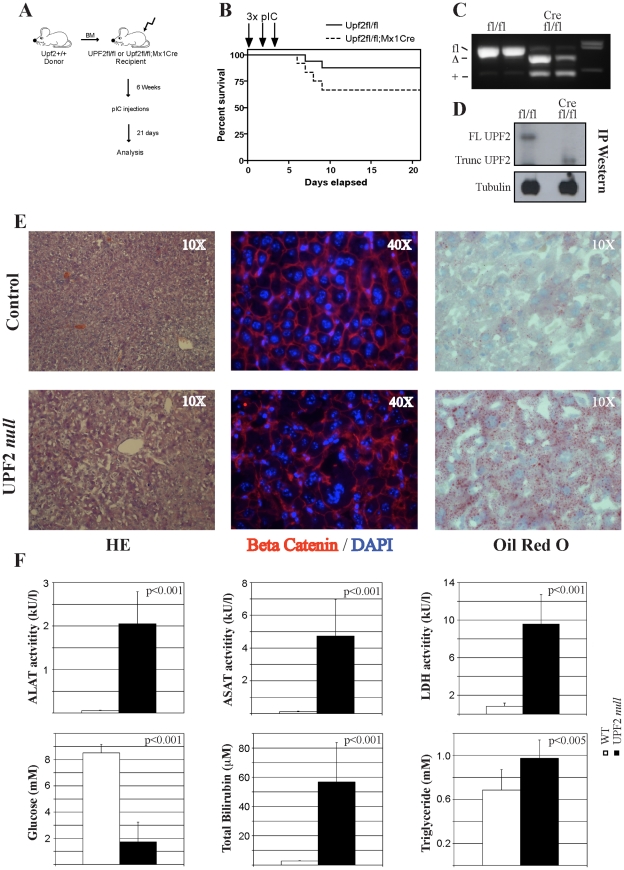
UPF2 is essential for homeostasis of the adult liver.(A) Experimental strategy for the induction of UPF2 loss in the adult liver of BM transplanted control (Upf2fl/fl) and Upf2fl/fl;Mx1Cre mice. (B) BM transplantation rescues the lethality of Upf2fl/fl;Mx1Cre mice. (C) Genotyping of BM transplanted (control and UPF2 null mice 3 weeks after the first pIC injection demonstrates efficient deletion in liver. UPF2 null adult livers also accumulate WT (+) cells of hematopoietic origin. (D) Western blot analysis of UPF2 and α-tubulin immunoprecipitates from control and UPF2 null adult livers. (E) Histological analysis using either immunohistochemistry of immunofluorescence techniques demonstrated loss in tissue organization (HE and β-catenin) and accumulation of lipids (Oil Red O) upon loss of UPF2 in adult liver. (F) Serum analysis of control and UPF2 null adult livers shows the accumulation of markers for liver damage (ALAT, ASAT, LDH and bilirubin), lowered glucose levels and triglyceride accumulation. The data represent the average of >8 mice in each group (mean +/− standard deviation).